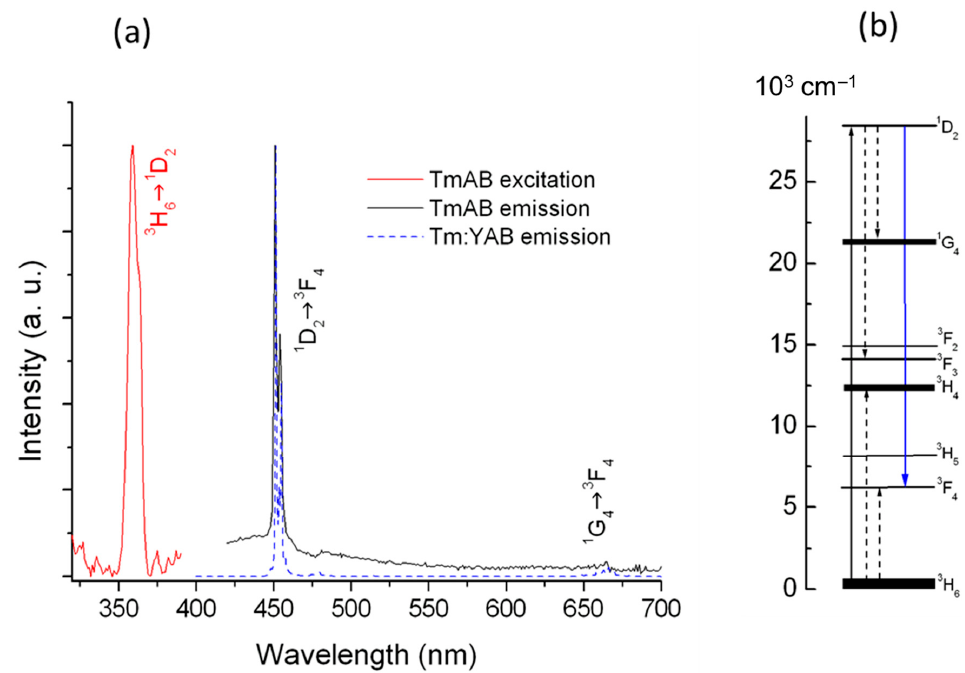
Figure 7. ( a ) Excitation (monitored wavelength: 450 nm) and emission (excitation at 358 nm) spectrum of TmAB. ( b ) Energy levels scheme and de-excitation mechanisms.